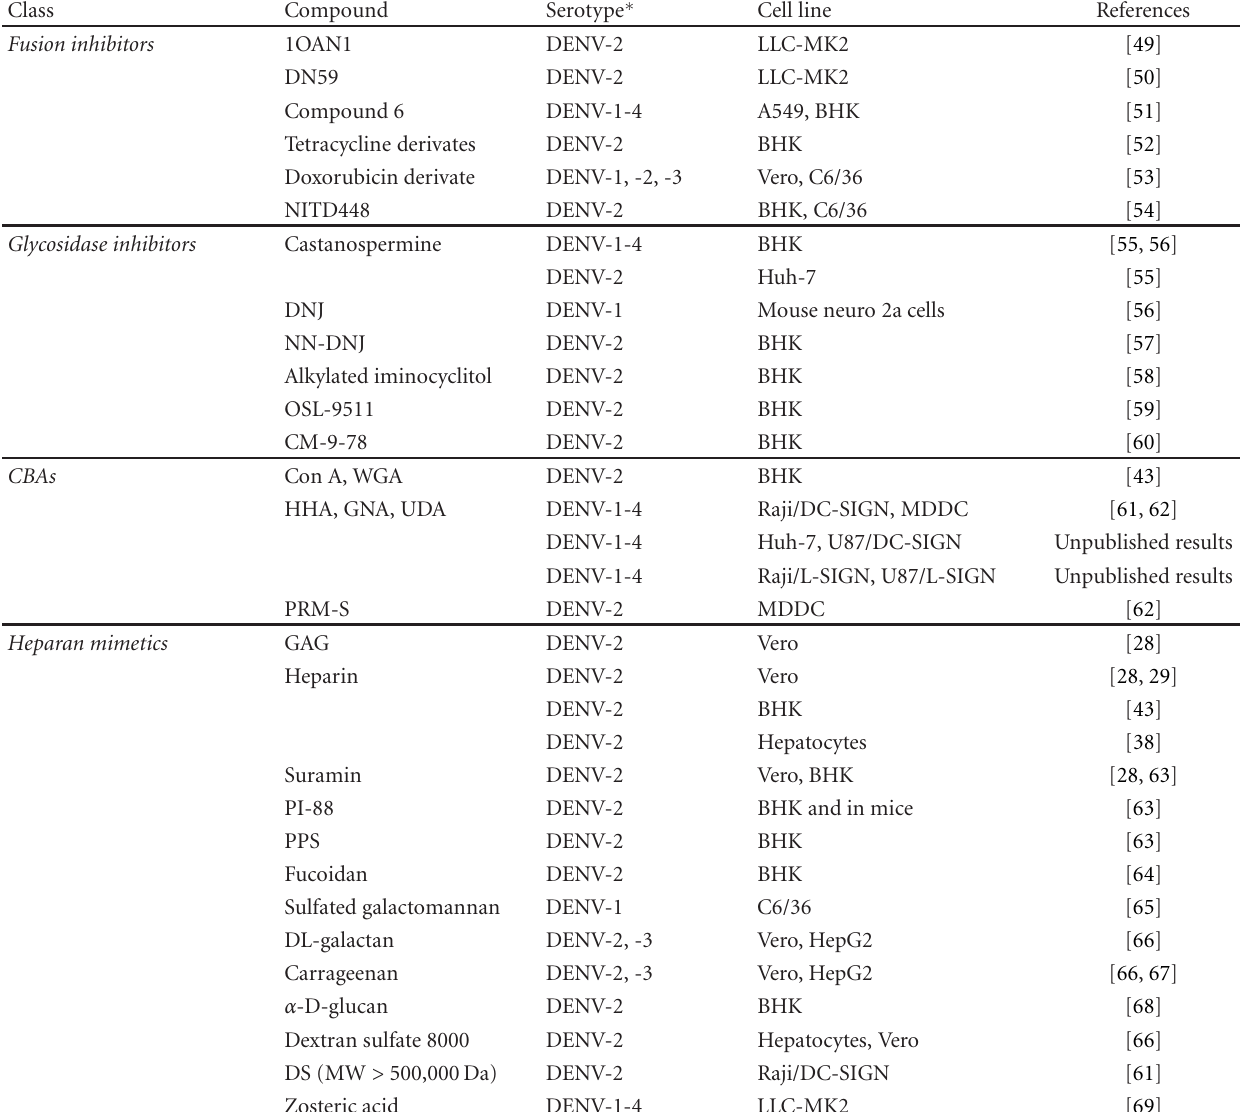
∗ Serotype: The serotype mentioned is the serotype that has been tested and found susceptibleto inhibition by the compound. Non-mentioned serotypes were not tested or could not be inhibited by the